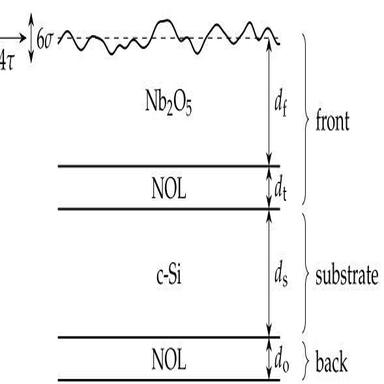
Schematic diagram of the structural model.